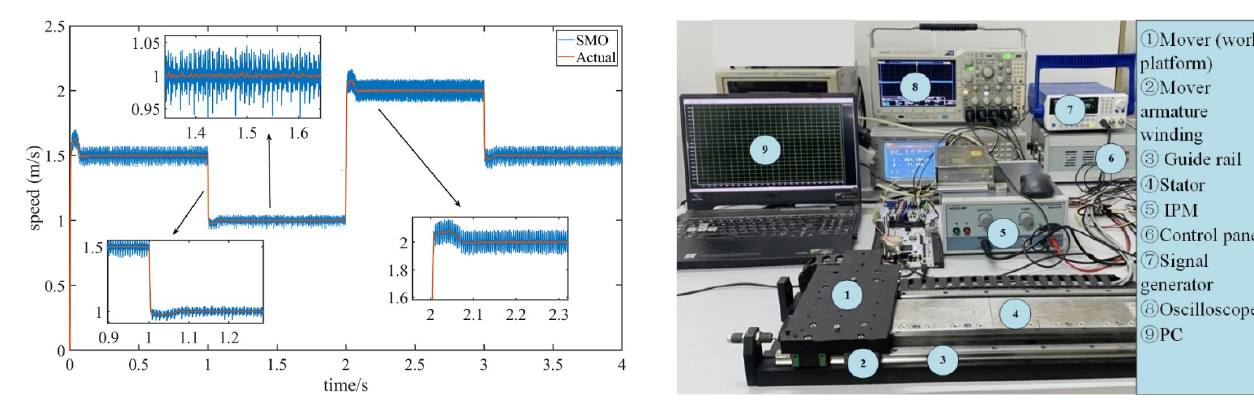
Figure 10. Speed tracking performance test of SMO. Figure 11. Linear motor diagram. IPM stands for intelligent power module.